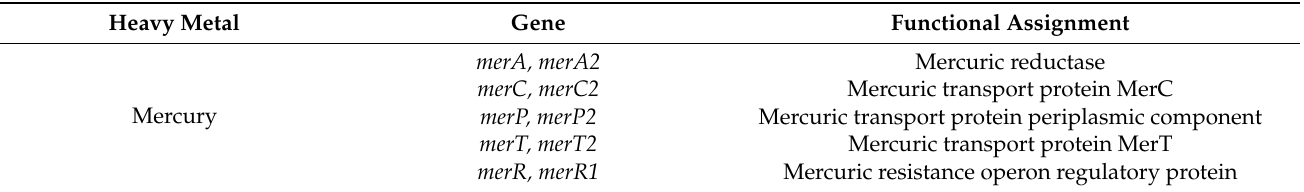
Table 2. Heavy metal resistance genes detected in A. hydrophila 34SFC-3 genome. The table shows the heavy metal target, the corresponding heavy metal resistance genes detected, and their functional assignment, according to Prokka